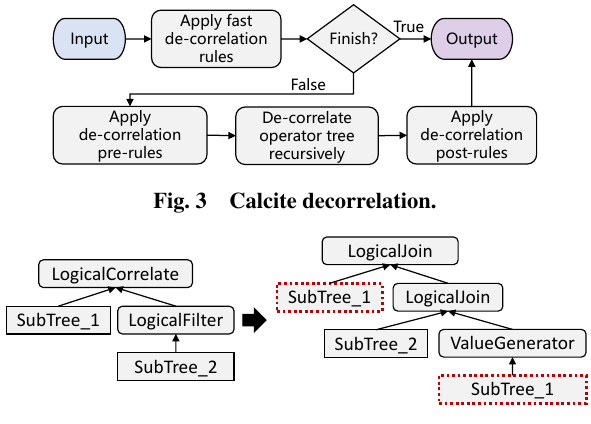
Fig. 4 Decorrelation